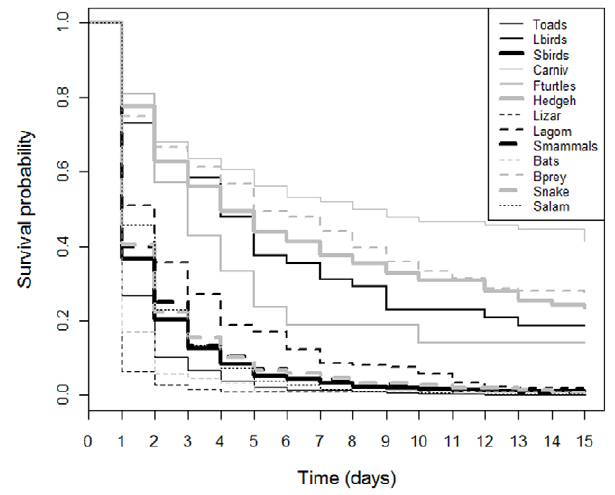
Figure 2. Separate survival curves for the 13 taxonomic groups; Toads: toads (including frogs), Lbirds: large birds (more than 200 g, and excluding raptors), Sbirds: small birds (less than 200 g), Carniv: carnivores; Fturtles: freshwater turtles, Hedgeh: hedgehogs, Lizar: lizards, Lagom: lago- morphs, Smammals: small mammals, Bats: bats, Bprey: birds of prey (diurnal and nocturnal), Snake: snakes, Salam: salamanders (including newts); (Kaplan-Meier estimates; N=4447; the length of time axis is limited to a maximum of 15